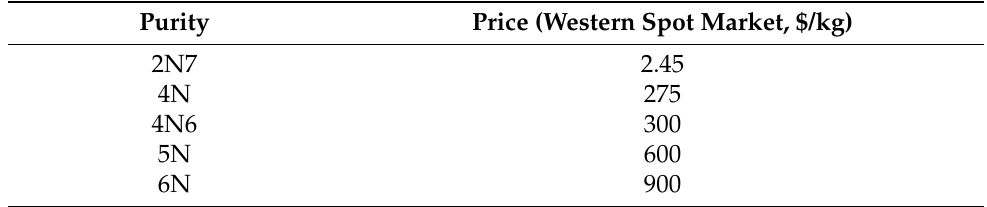
Table 3. The price per kilogram of aluminum in the western market in 2021, data from [18,19].